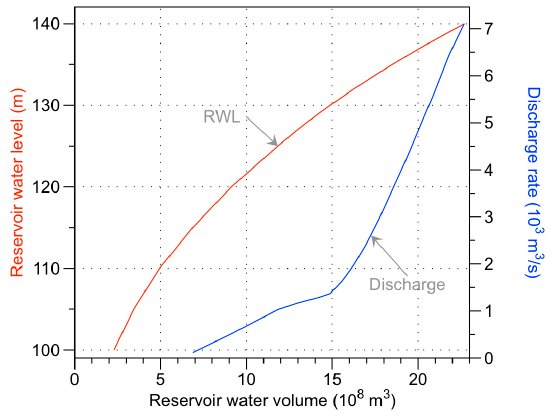
Figure 2. Relationship between water level, water volume and discharge rate of the Meishan Reservoir. RWL: reservoir water level.